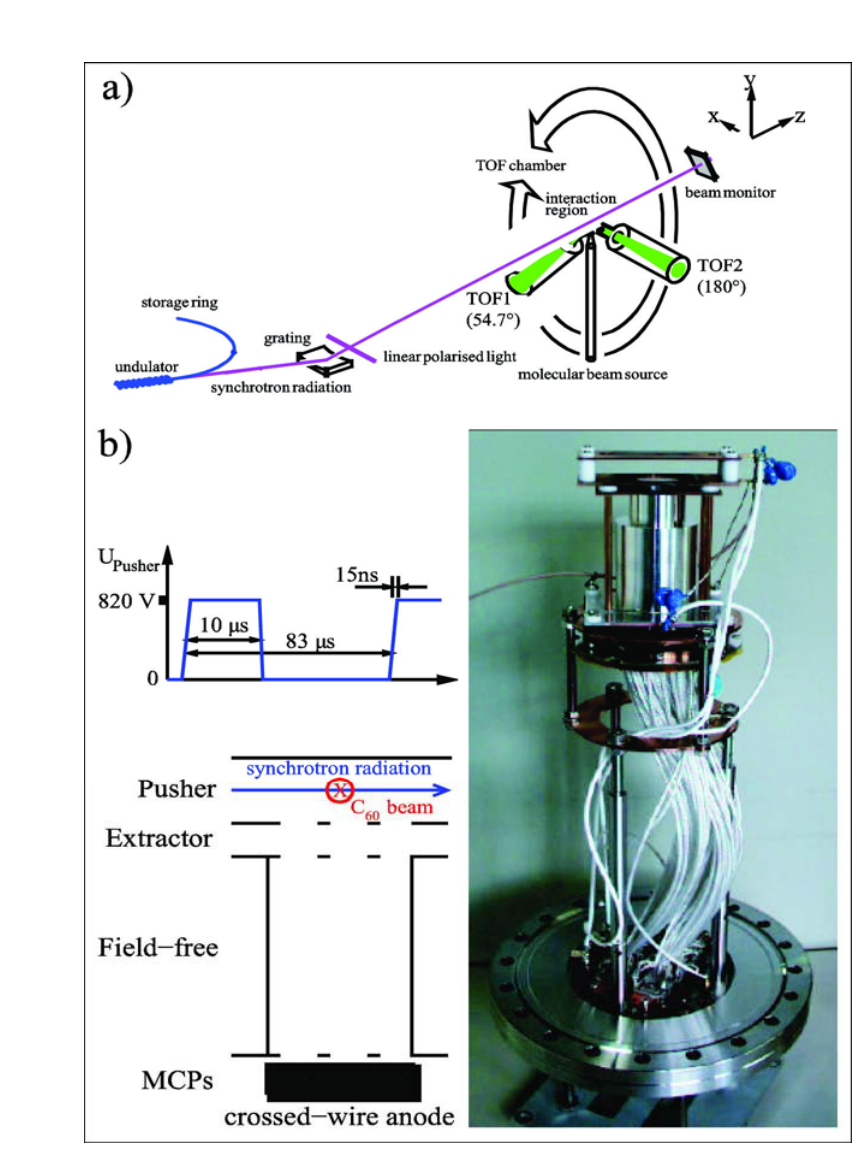
Figure 1 – Sketch of the experimental set-up. (a)beam source with the electron time-of- flight (TOF) spectrometer. (b)schematic view and picture of the ion spectrometer Рис . 1 – Изображение экспериментального устройства ( а ) источник света с